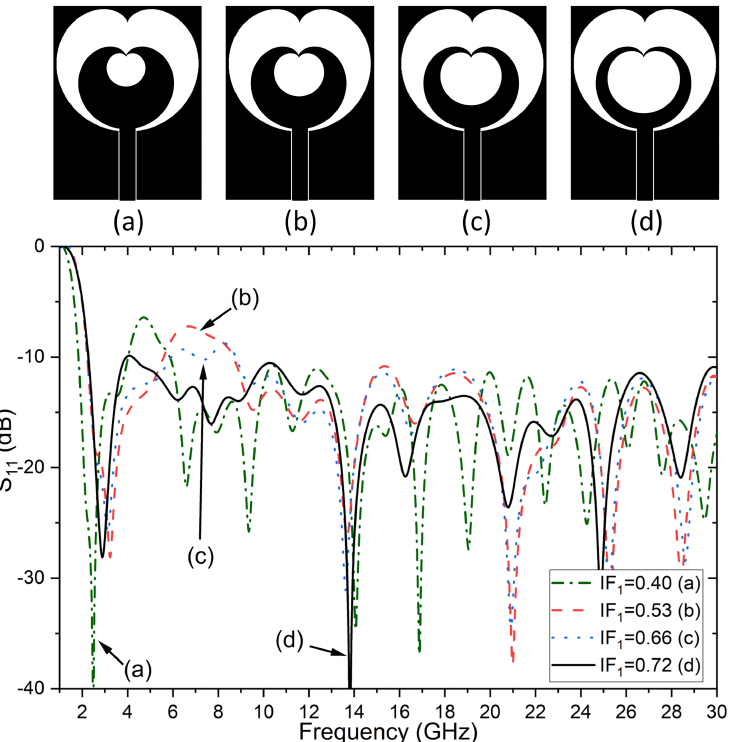
Figure 4. The simulated reflection coefficients of the first order fractal antenna for different iteration factors IF 1 = a 3 / a 2 obtained by changing the value of parameter a 3 when a 1 = 6.6 and a 2 = 4.55: ( a ) a 3 = 3.64, ( b ) a 3 = 4.82, ( c ) a 3 = 6.06 and ( d ) a 3 =